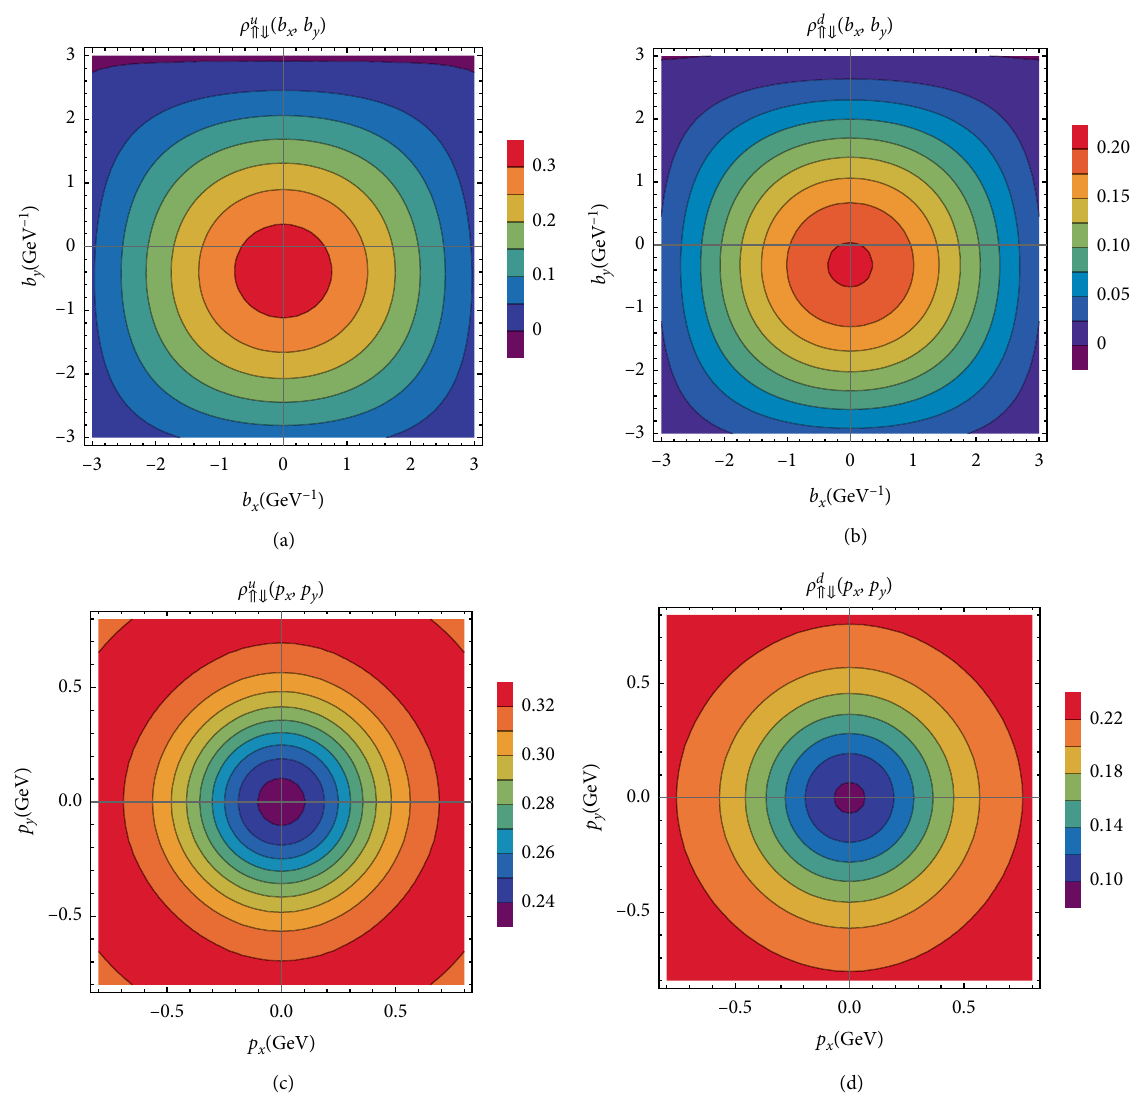
Figure 4: The plot of Wigner distribution 휌 (left panel) and 𝑑 -quark (right